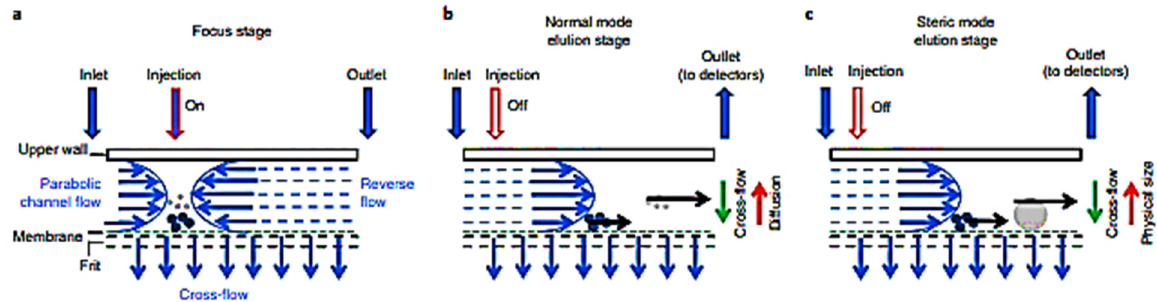
Figure 4. Diagrammatic representation of the AF4’s operation. ( a ) In the elution step, the fine blue arrows represent the channel flow (horizontal arrows) and cross-flow (vertical arrows); the fine black arrows represent the channel flow that transports the nanoparticles through the channel (the lengths of the arrows represent magnitude of the flow rate); the thick blue arrows represent the inlet and outlet flows; and the red-outlined arrows represent the injection flow (the filled arrow indicates the injection flow is ON and the empty arrows indicate the injection flow is OFF). All of the arrowheads point in the direction of the flow. Fine green arrows indicate the direction of particle movement caused by cross-flow; fine red arrows in parts ( b , c ) denote the direction of particle movement due to their diffusion ( b ) or the physical position of particles in the channel as a result of their physical sizes ( c ). [35] Reproduced with permission from H. Zhang and D. Lyden, Nat. Protoc.; published by Nature 2019.